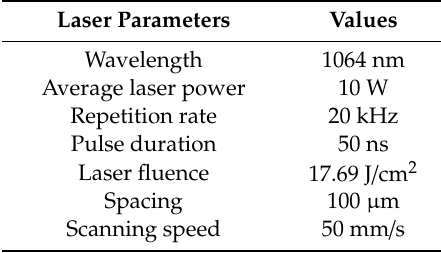
Table 2. Laser parameters performed to ablate the IN718